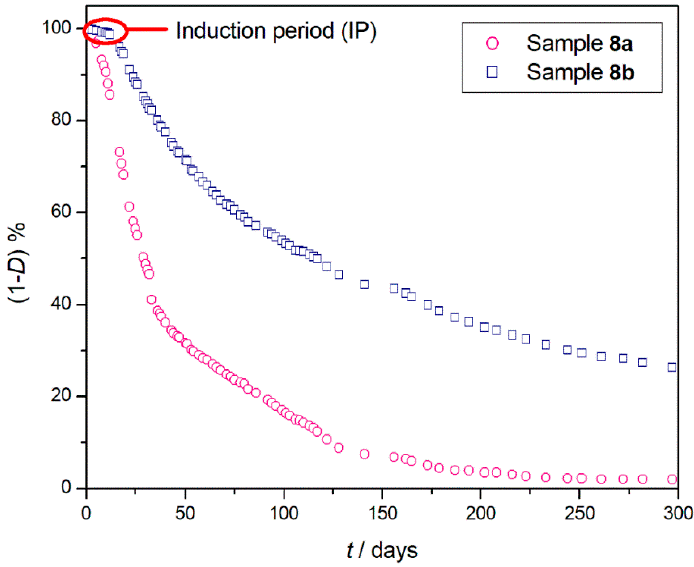
Figure 5. Percentage of undegraded sample (1 − D )% at 150 °C as a function of heating time ( t ) for PLA (sample 8a ) and (sample 8b ) after 300 days of degradation.